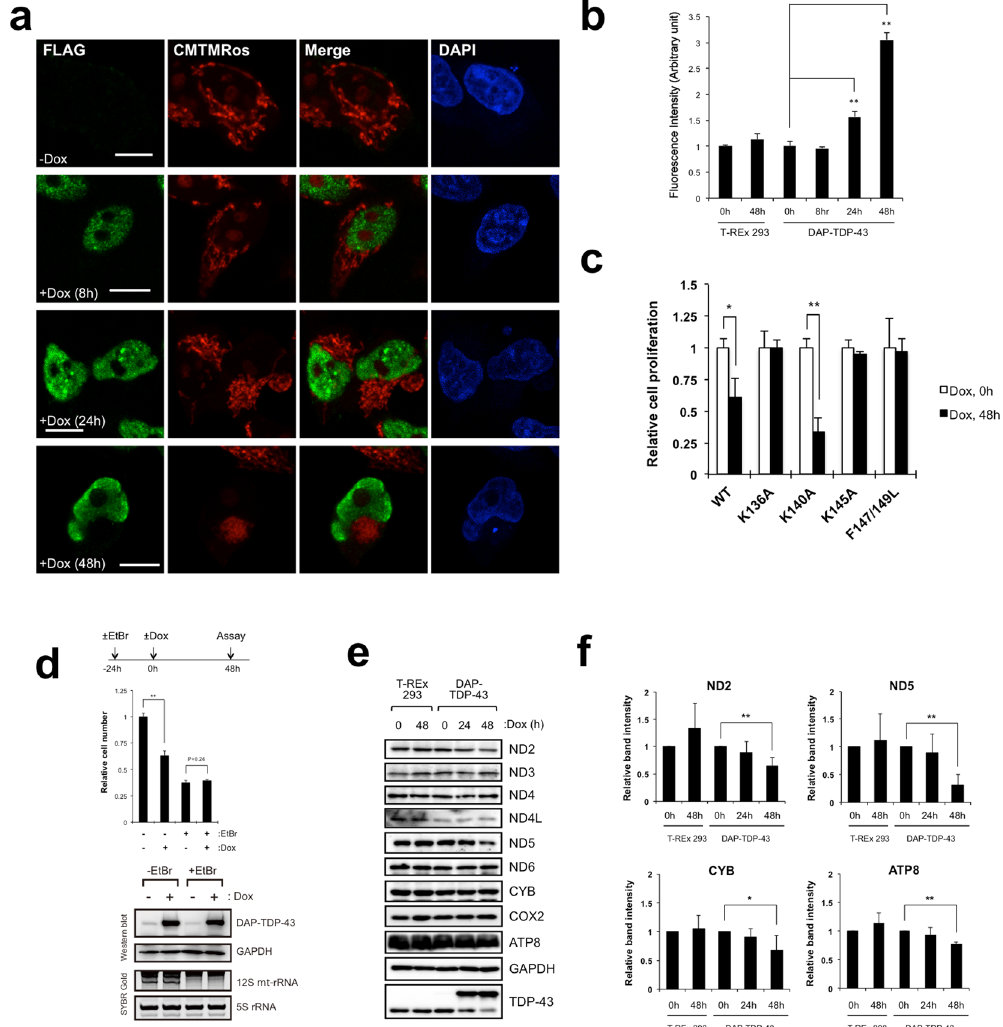
Figure 6. TDP-43 overexpression impairs mitochondrial function. ( a ) Exogenous TDP-43 was detected in DAP-TDP-43–expressing T-REx 293 cells by immunocytochemical analysis with anti-FLAG (green). Mitochondria were stained with CMTMRos (red) and nuclei with DAPI (blue). Cells were stained at 8, 24, or 48 h after doxycycline (Dox) induction. Bars, 10 µ m. ( b ) Production of reactive oxygen species was measured in DAP-TDP-43–expressing T-REx 293 cells harvested at 0, 8, 24, and 48 h after Dox induction and in T-REx 293 cells harvested at 0 and 48 h after Dox treatment. The amount of reactive oxygen species (fluorescence intensity; arbitrary unit) per cell is relative to cells without Dox induction. Values are the average ± SD of three independent experiments. ** P < 0.01 (unpaired t test). ( c ) Proliferation of T-REx 293 cells expressing DAP-TDP-43 or its point mutants relative to that of cells without Dox induction was measured by cell counting. Values are the average ± SD of three independent experiments. * P < 0.05. ** P < 0.01 (unpaired t test). ( d ) DAP-TDP-43-expressing T-REx 293 cells treated with ( + EtBr) or without EtBr ( − EtBr) for 24 h were induced with Dox ( + Dox) for 48 h, and numbers of cells relative to both − EtBr and − Dox cells were counted. ** P < 0.01 (unpaired t test). The expression of DAP-TDP-43 was examined by western blotting with anti-TDP-43 and anti-GAPDH. The inhibition of mt transcription by EtBr was confirmed with SYBR Gold staining of 12S mt-rRNA. ( e , f ) Mitochondrial proteins prepared from T-REx 293 cells or from DAP-TDP-43-expressing T-REx 293 cells harvested at 0, 24, and 48 h after Dox induction (Dox) were analysed by western blotting with the indicated antibodies ( e ). Intensities of the immunostained bands in e were quantified relative to those at 0 h of Dox induction. Only the proteins for which the level changed upon overexpression of TDP-43 are shown ( f ). Data are the mean ± SD, n = 3–5. * P < 0.05, ** P < 0.01 (paired t